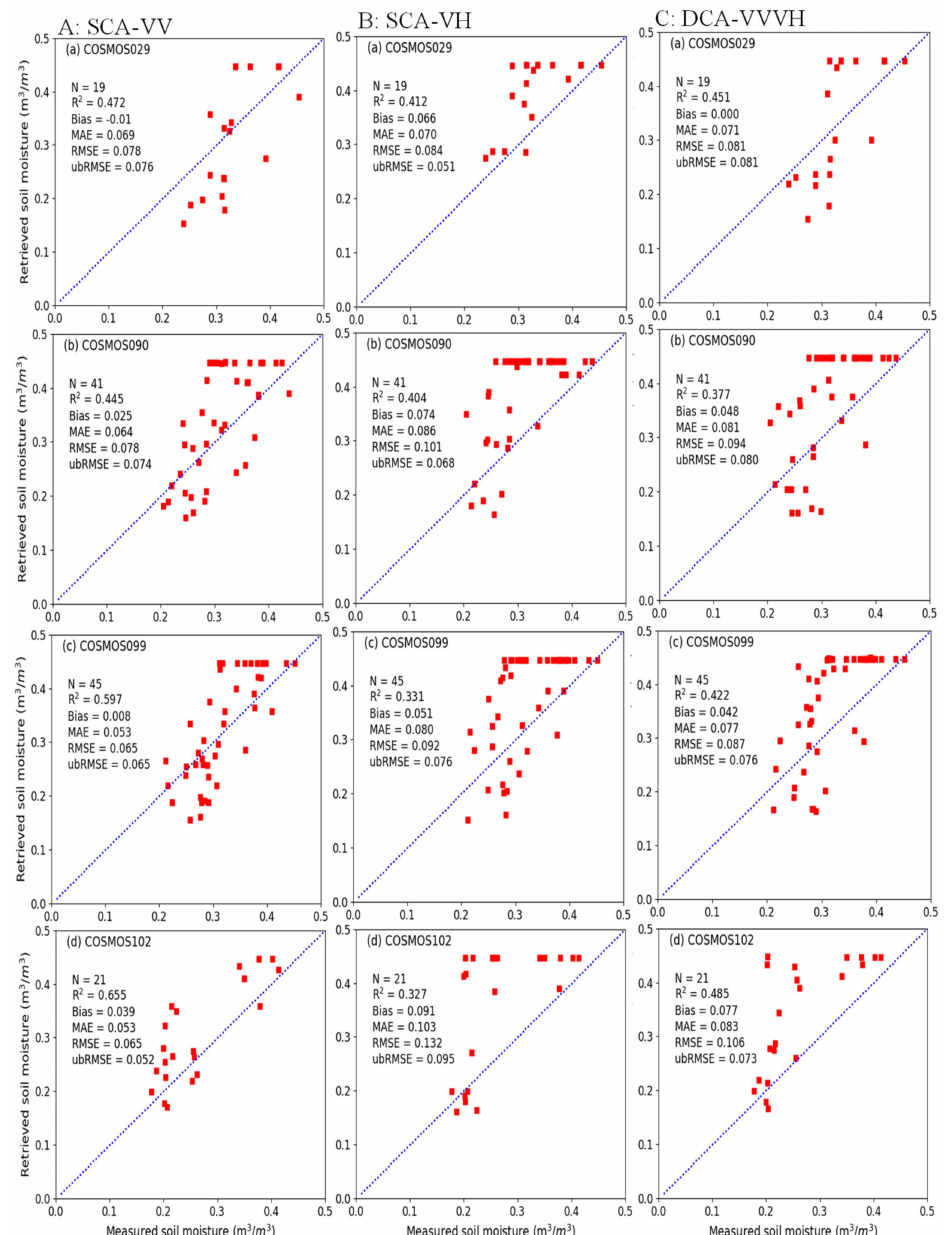
Figure 7. Soil moisture retrievals for the average-then-calculate strategy against measurements from the four COSMOS sites using: (1) SCA-VV scheme ( A : left panel); (2) SCA-VH scheme ( B : middle panel); and (3) DCA-VVVH scheme ( C : right panel). From top to bottom ( a – d ), each subplot represents the validation over four di ff erent COSMOS sites. Validation is conducted with p <